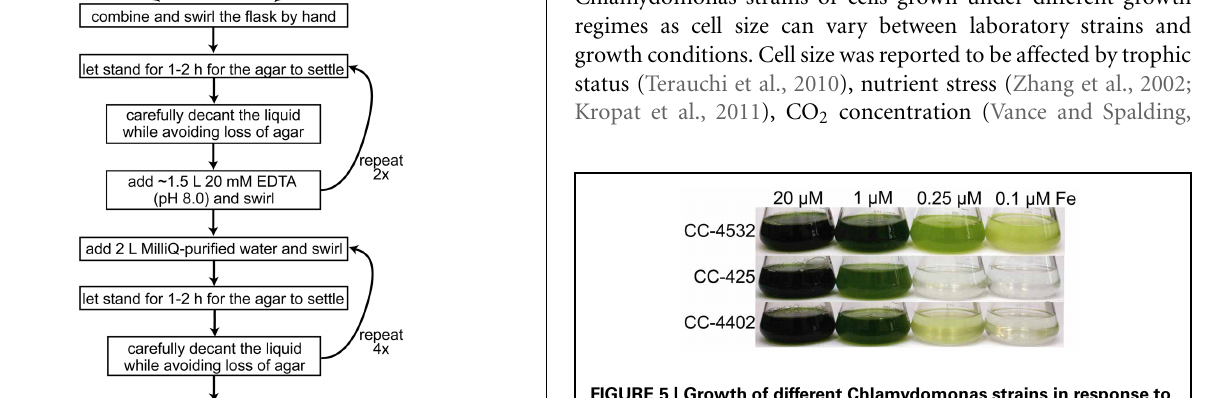
FIGURE 5 | Growth of different Chlamydomonas strains in response to iron supply. CC-4532 and CC-4402 are cell wall-containing strains, whereas CC-425 represents a cell wall-less strain. Cultures were inoculated at 1 × 10 4 cells/mL and grown for 10 days in TAP (Tris-acetate-phosphate) supplemented with iron to the indicated concentrations at 24 ◦ C and shaken at 180rpm under constant illumination of 60–80 µ mol/m 2